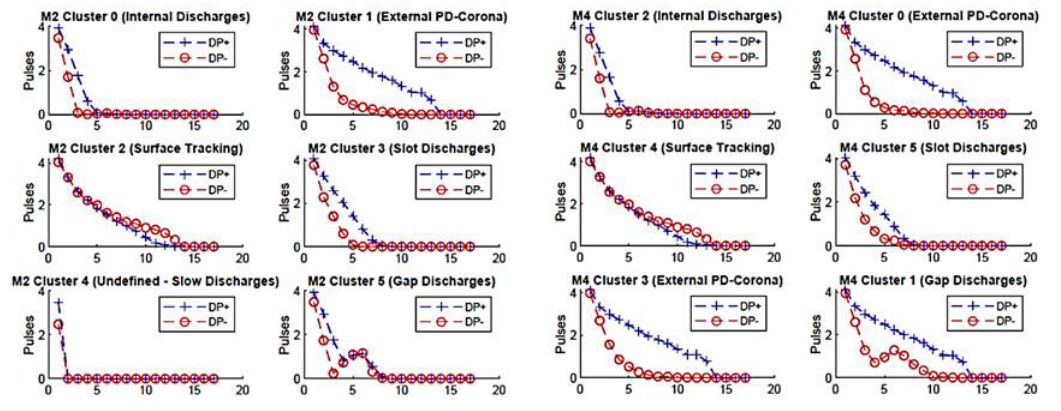
Figure 7. Partial discharges’ centroids.